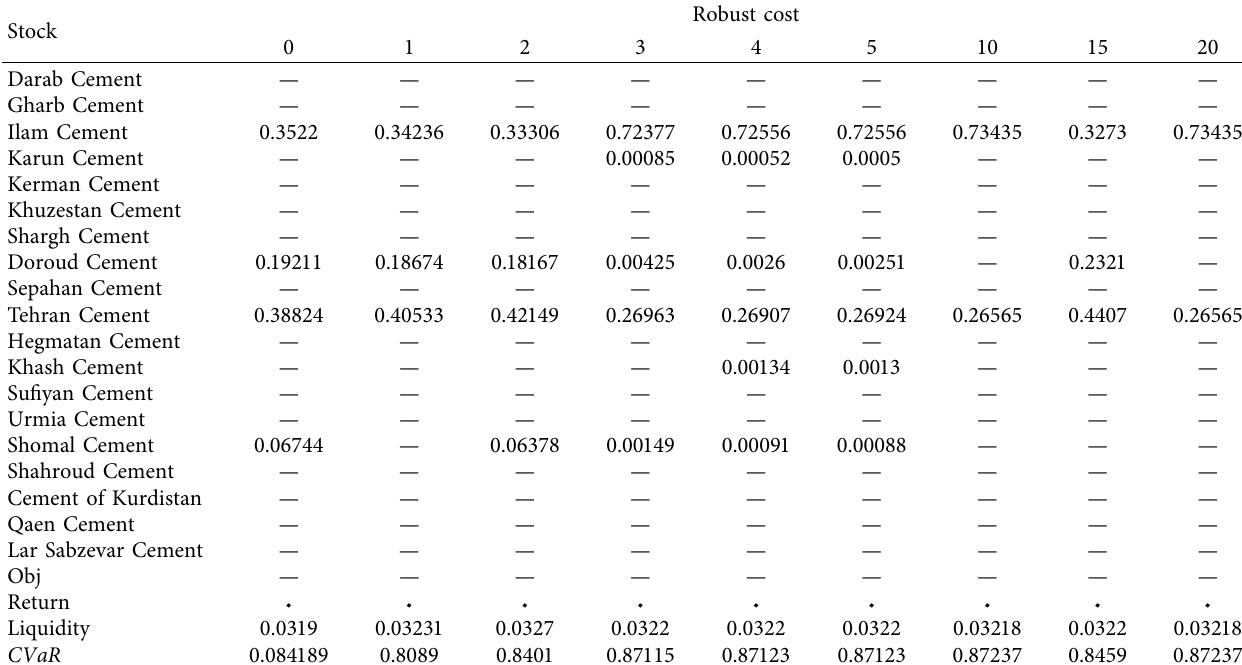
Table 2: Forming an optimal stock portfolio considering various robust costs.